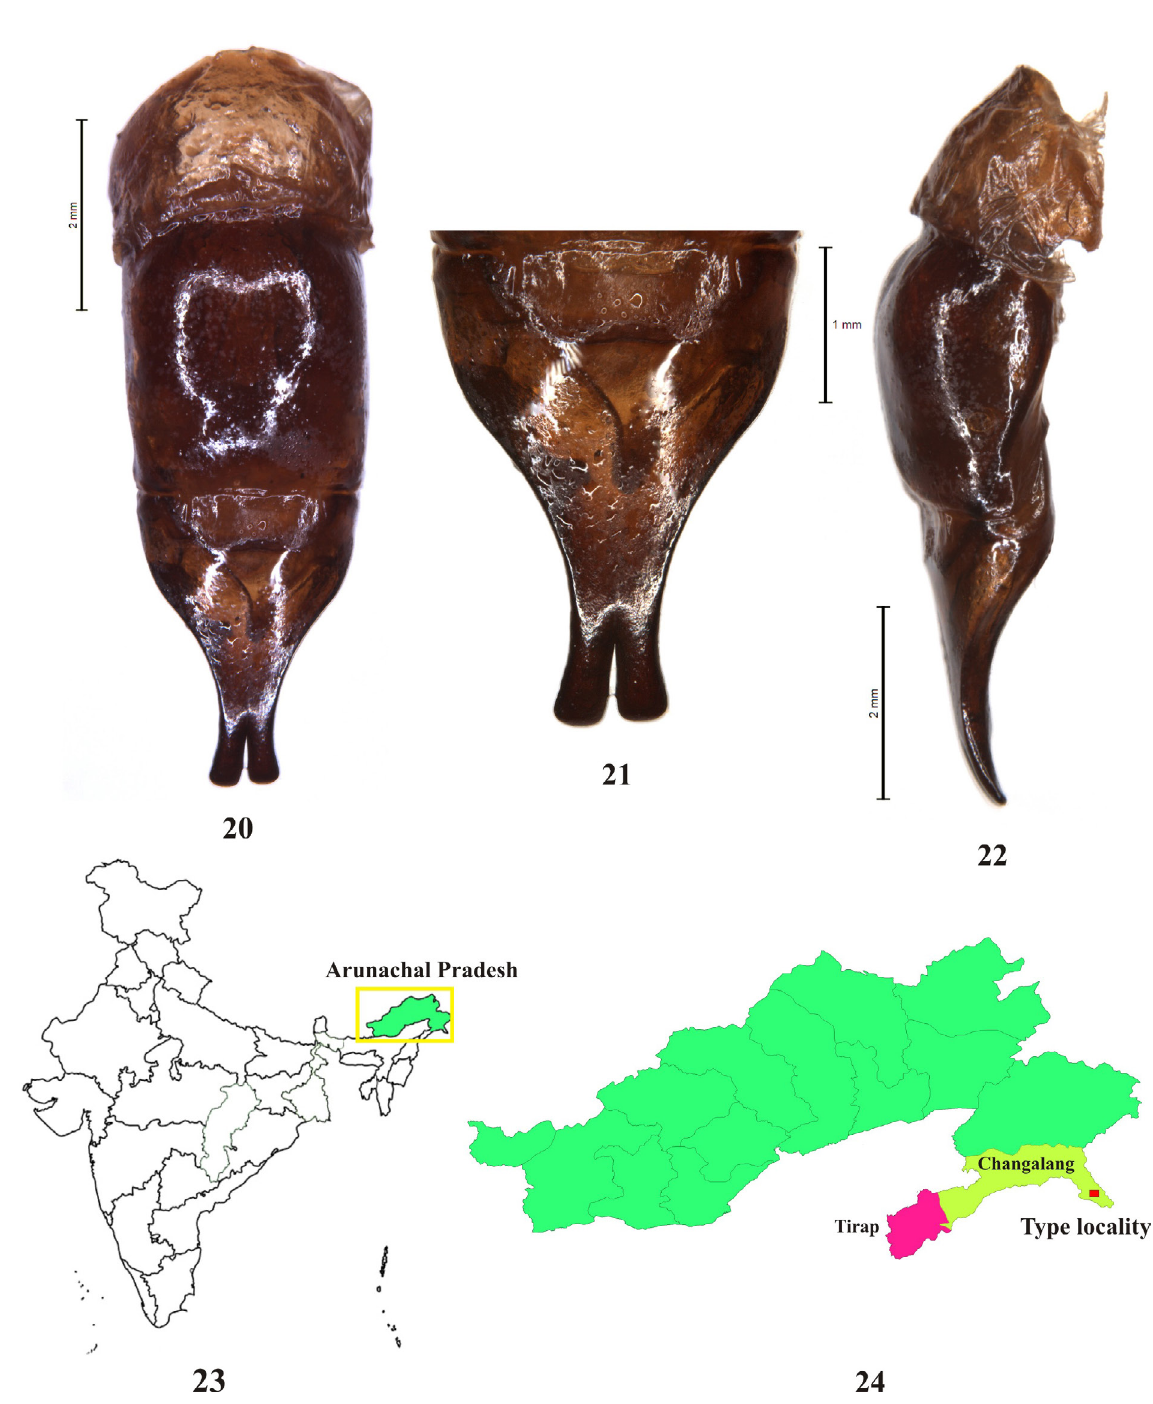
Figs 20–24. Pukupuku arunachalensis sp. nov, holotype, ♂. 20 . Aedeagus (dorsal view). 21 . Parameres (dorsal view). 22 . Aedeagus (lateral view). 23 . Map of India. 24 . Map of the state of Arunachal Pradesh showing the type